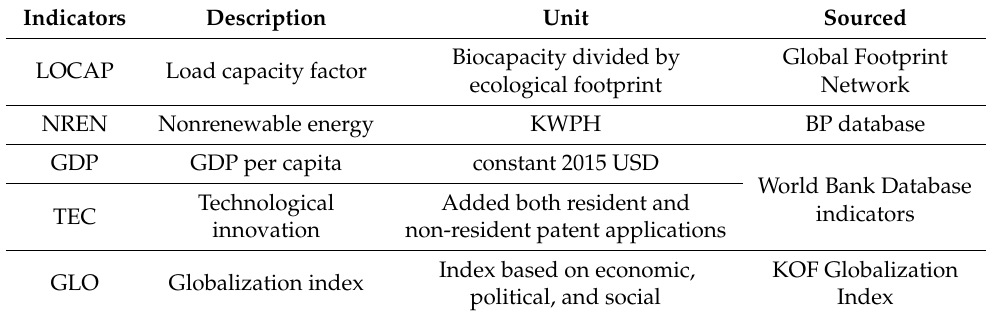
Table 1. Description of the variable. Indicators